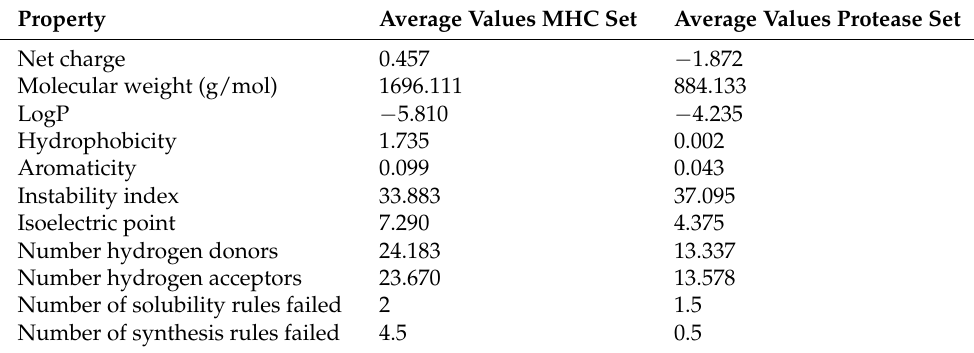
Table 1. Average values of properties calculated with PepFun for the datasets of peptides associated to the MHC class II protein and the Granzyme B protease. We report the average net charge based on pka values of each amino acid at pH 7, the molecular weight calculated in g/mol using the SMILES representation of the peptide, the Crippen estimation of the octanol/water partition coefficient (logP) available in the RDKit [24], the average hydrophobicity from the Eisenberg scale [23], the isoelectric point and aromaticity obtained from the ProtParam package [9], the instability index from ProtParam as an estimate of the stability of the peptide in a test tube [9], the number of hydrogen bond acceptors and donors calculated using the SMILES representation, and the number of failed solubility and synthesis empirical rules [26]. We note that the higher the number of rules violated, the lower the probability to be solubilized or synthesized